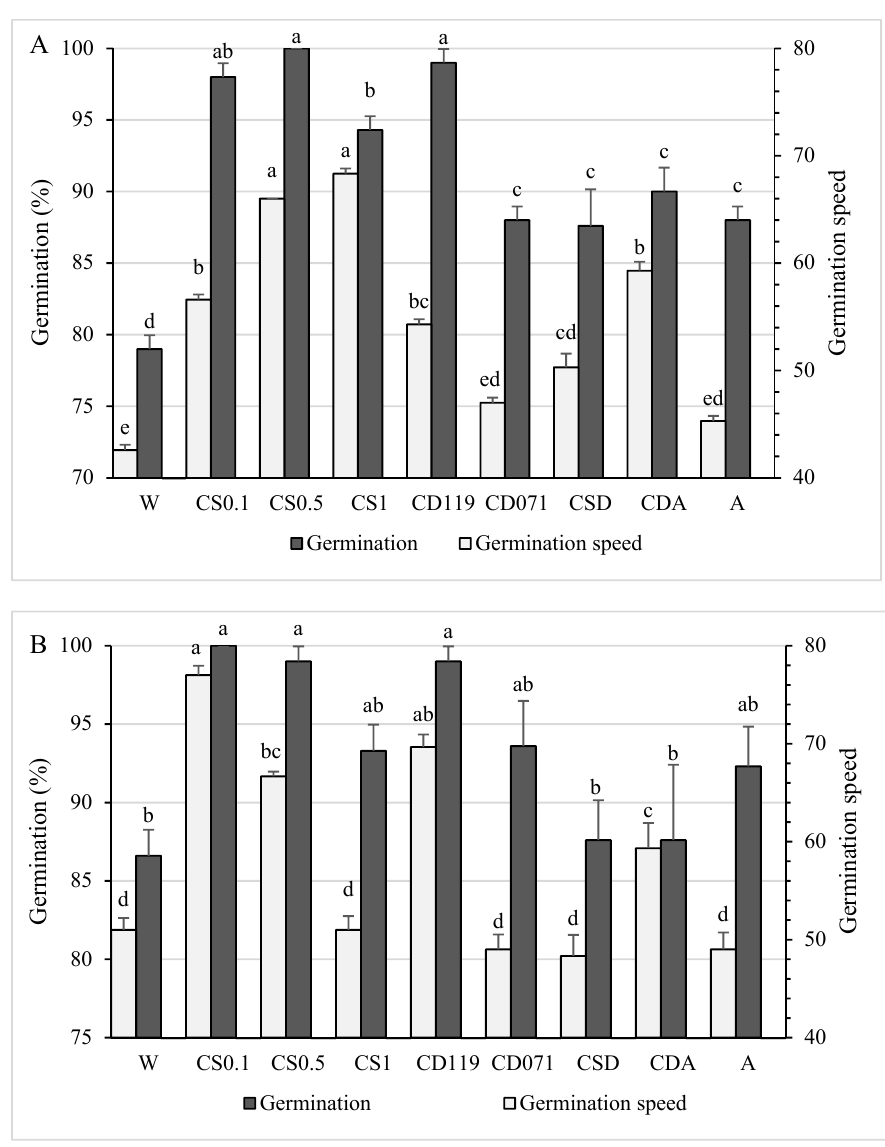
Figure 3. Effect of chitosan coating on germination and germination speed. ( A ) Bean seeds. ( B ) Sesame seeds. Means with the same letter indicates that they are statistically equal according to Tukey’s test ( p < 0.05).